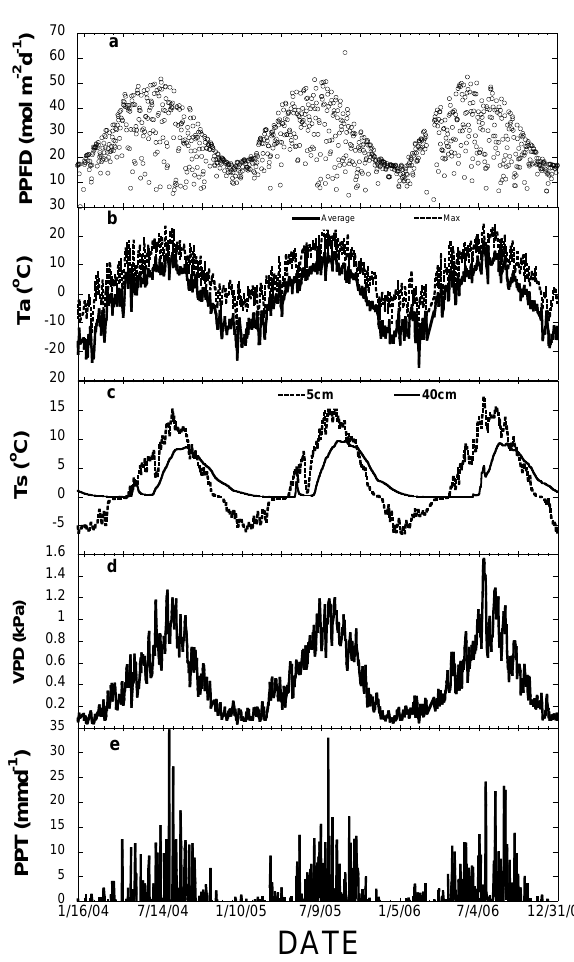
Fig. 1 Seasonal variability of (a)photosynthetically active radiation ( PPFD ), (b) average daily air Fig. 1. Seasonal variability of (a) photosynthetically active radia- tion (PPFD), (b) average daily air temperature ( Ta ), (c) soil temper- temperature ( Ta ), (c) soil temperature at the depth of 5 and 40 cm (Ts), (d) vapor pressure deficit ature at the depth of 5 and 40cm ( T s ), (d) vapor pressure deficit (VPD), and (e) daily total precipitation (PPT).The lines are plotted ( VPD ), and (e) daily total precipitation ( PPT ).The lines are plotted from January 1 to December from 1 31.